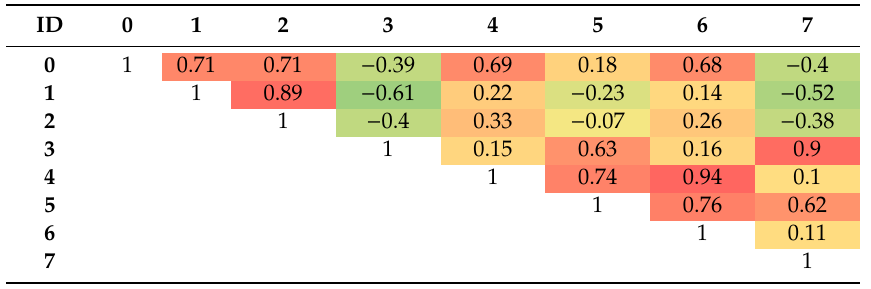
Table 5. Correlation table at study points in the Inside Passage,